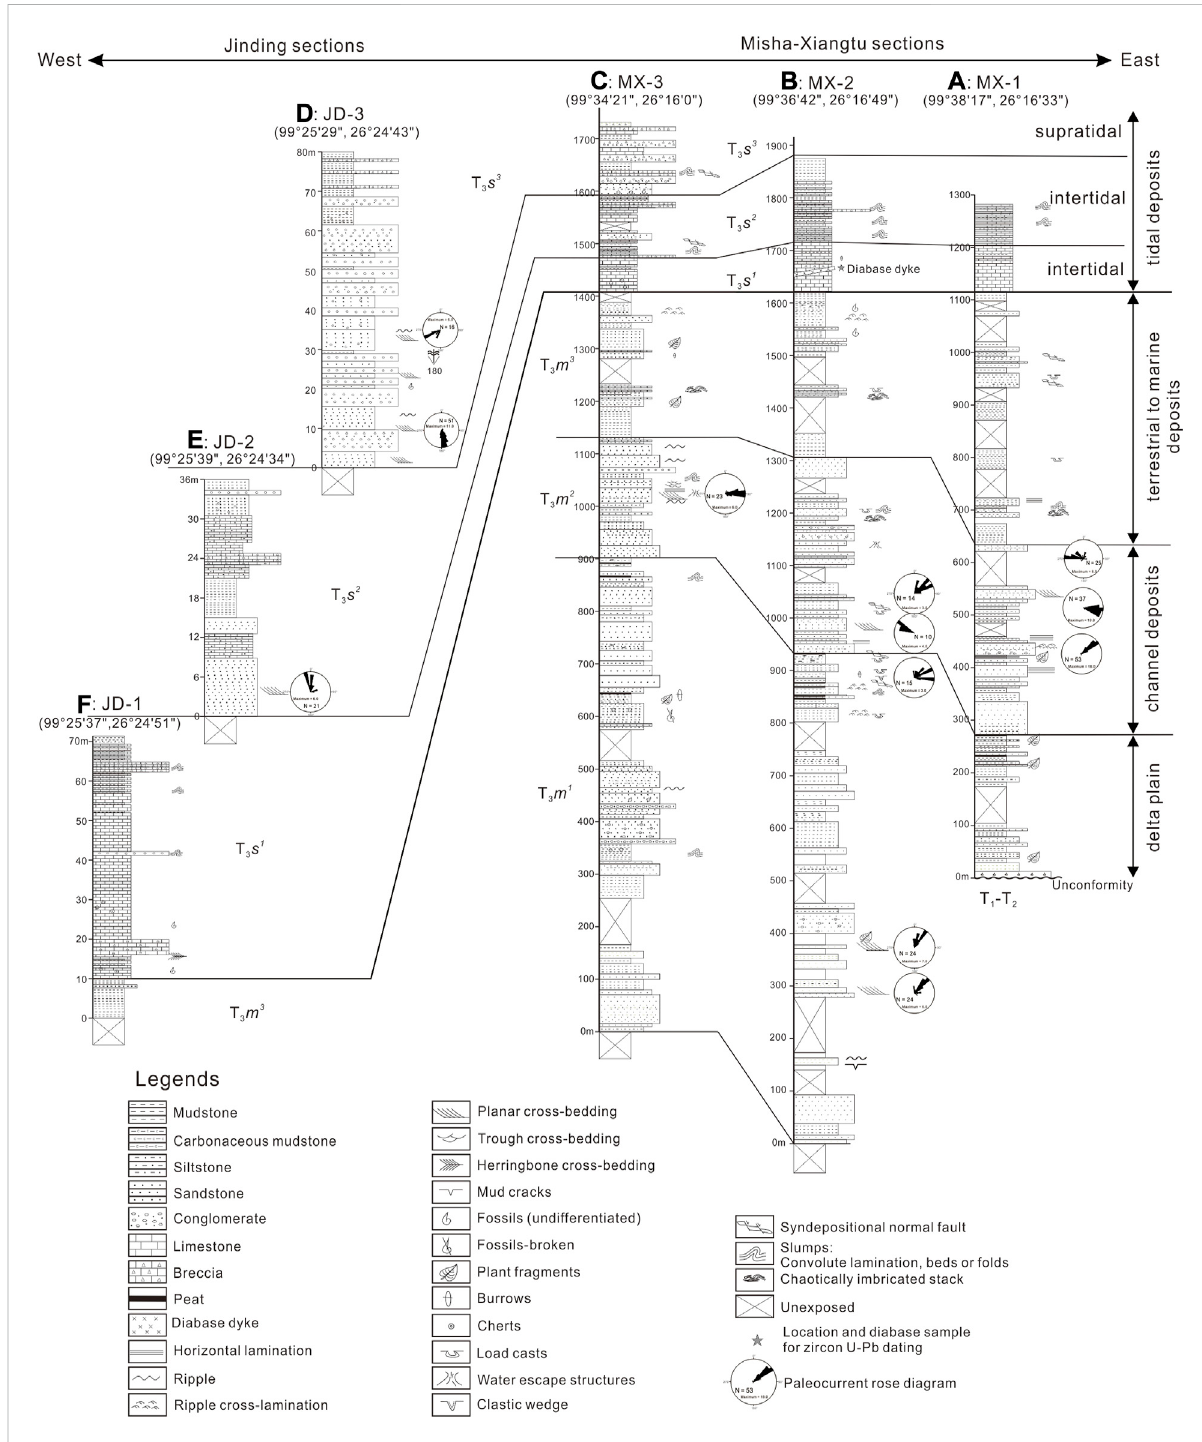
Measured sedimentary logs of the Maichuqing and Sanhedong formations. See Figure 2A for the locations of each section. From east to west, the three sections (A – C) along the Misha – Xiantu pro fi le show successive variation in sedimentary features of the Maichuqing and Sanhedong formations,whereastheJindingsections (D – F) showthelower,middleandupperpartoftheSanhedongFormation.Notethatthepaleocurrentdata of the Jinding section are not used to discuss because of the uncertainty in rotation of the related small fragments (see Figure